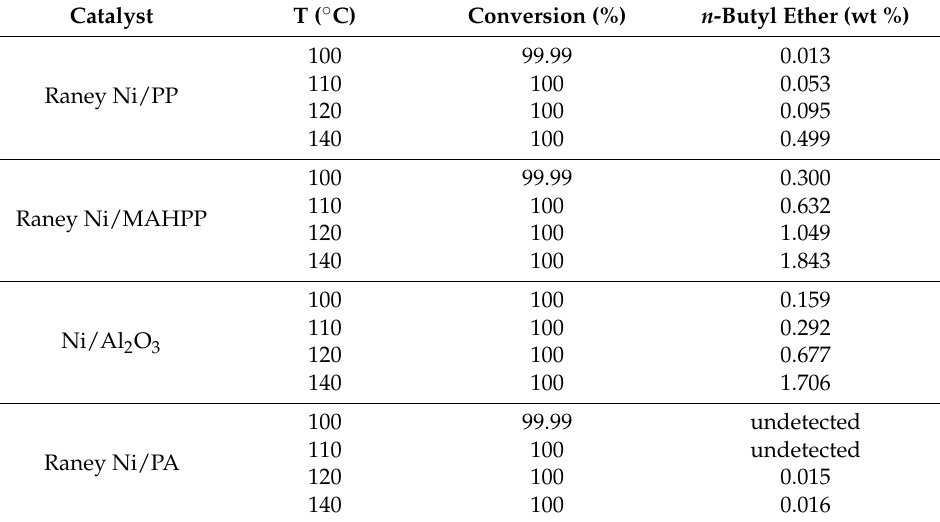
Table 1. Hydrogenation of n -butyraldehyde with different catalysts over 100–140 ˝ C [19]. Reproduced from Ref. [19] with permission from the Royal Society of